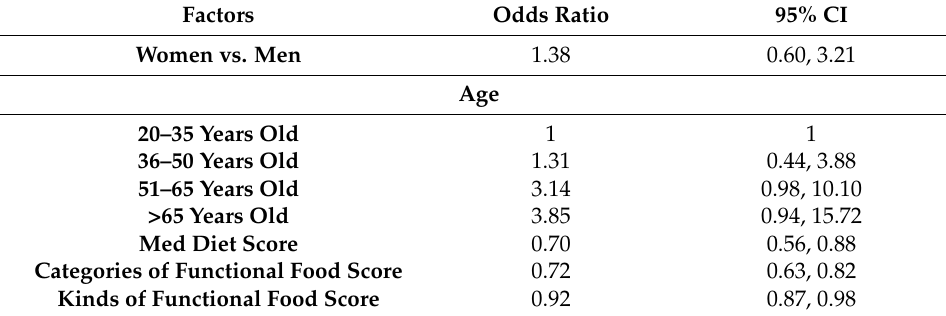
Table 6. Multifactorial analysis results for the evaluation of the relationship between the scores for functional food categories, functional food kinds, and dietary habits and gastrointestinal diseases, based on Mediterranean diet